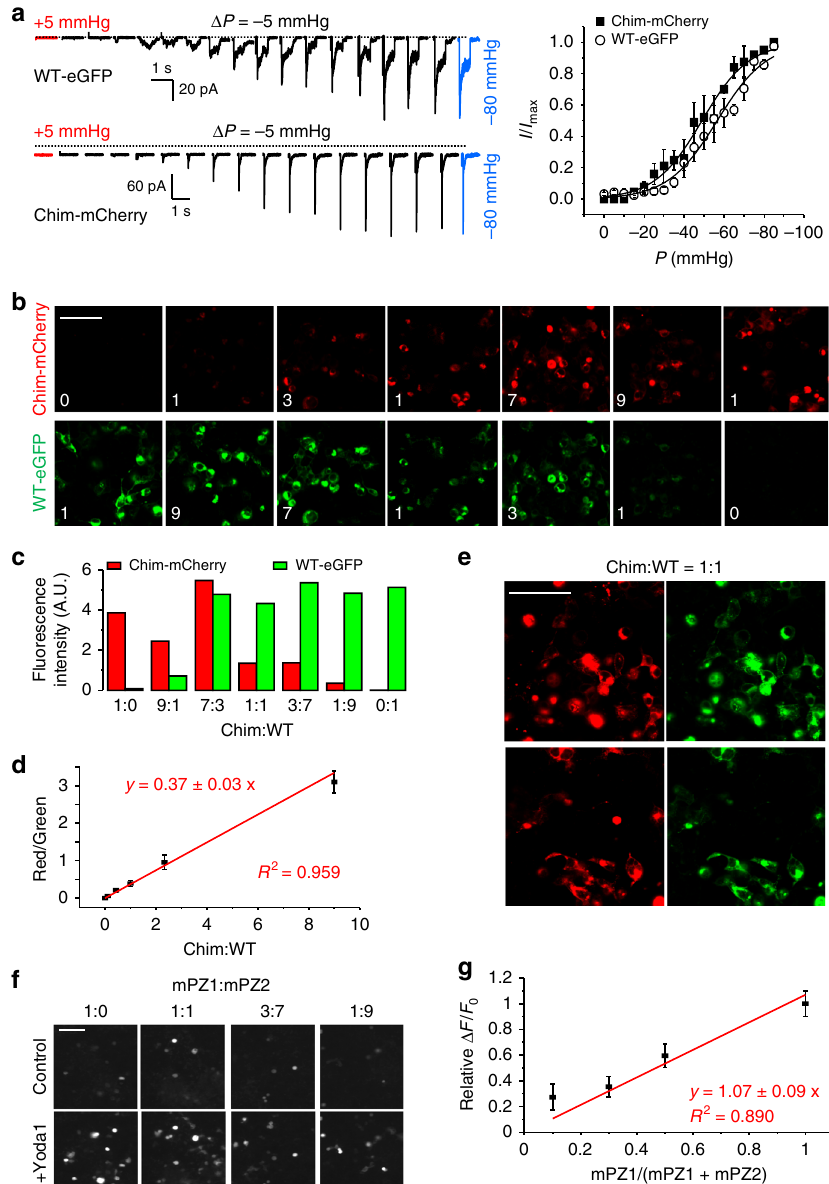
Fig. 4 Ratiometric expression of hybrid channels. a Left, pressure-induced ionic current traces from WT-eGFP and Chim-mCherry. Right, normalized peak current plotted against pressure for WT-eGFP (open circles) and Chim-mCherry (full squares). The plots are the average of at least fi ve independent recordings. Dotted lines indicate zero current level. b Example of confocal fl uorescence images showing separate eGFP emission (bottom row) and mCherry emission (top row) from HEK 293T cells co-transfected with WT-eGFP and Chim-mCherry. The number in each image indicates the relative proportion of each transfected plasmid. c Histograms showing the fl uorescence intensity from images displayed in b for different ratiometric transfections. d Linear fi tting of the relative mCherry/eGFP emission (red/green) as a function of the relative proportion of Chim/WT transfected plasmids (Chim:WT). The experiment was repeated three times. e Examples of confocal images from cells transfected with equimolar amounts of plasmids encoding WT-eGFP and Chim-mCherry. The dynamic range of the images has been altered to highlight the co-localization of both fl uorescence channels. f Examples of calcium-sensitive fl uorescence images obtained using GC6 before (control) or after incubation with 30 µ M Yoda1 ( + Yoda1) in cells transfected with the indicated ratios of plasmids encoding mPZ1 and mPZ2. g The Δ F / F 0 obtained for each ratio tested in f was normalized to the Δ F / F Δ F / F 0 obtained in cells transfected only with mPZ1 (relative 0 ) and plotted as a function of the proportion of mPZ1 plasmid in the plasmid mixture (mPZ1/ (mPZ1 + mPZ2)). A linear fi t to the data is shown in red. The experiment was done in duplicate and repeated four times. In a , d , g , error bars = s.e.m. Scale bar in b , e , f = 50 µ